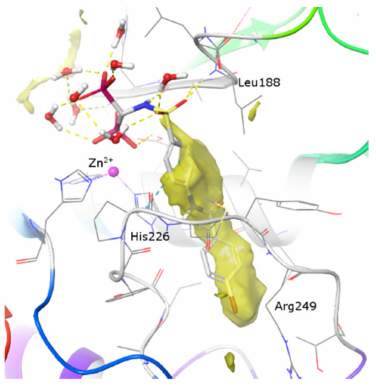
Figure 5. Superimposition of the docking pose of compound 9 (grey carbon atoms) to the hydrophobic molecular interaction fields (yellow transparent surface) calculated by SiteMap in the MMP-9 binding site (isovalue = − 0.8, PDB ID: